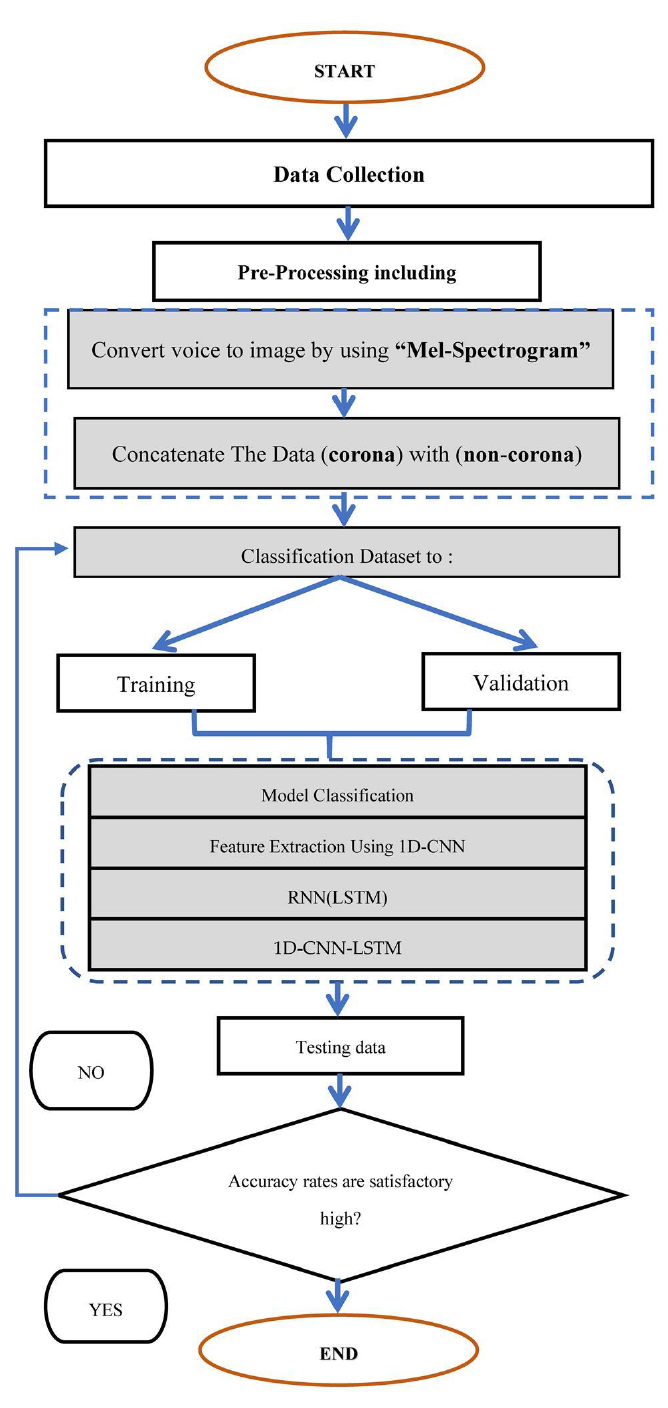
Figure 2. General flowchart diagram of the research method .